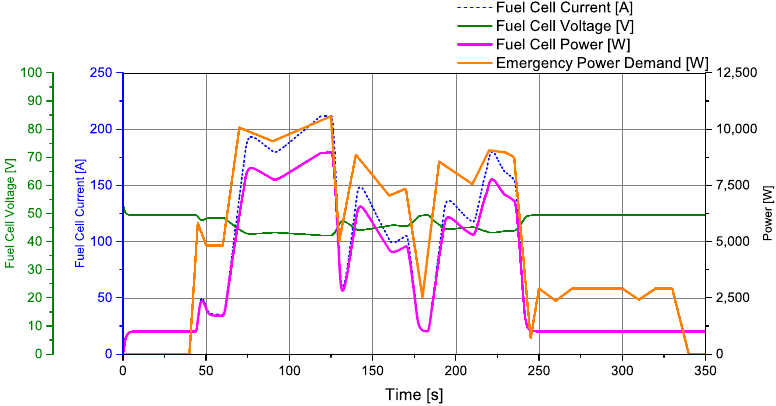
Figure 15. Fuel cell current and voltage variations during